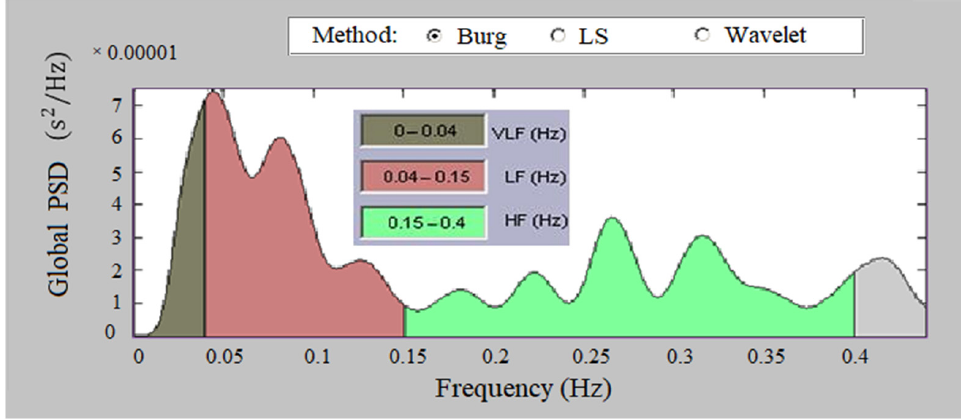
Figure 11. Global PSD of tachycardia, Burg method.